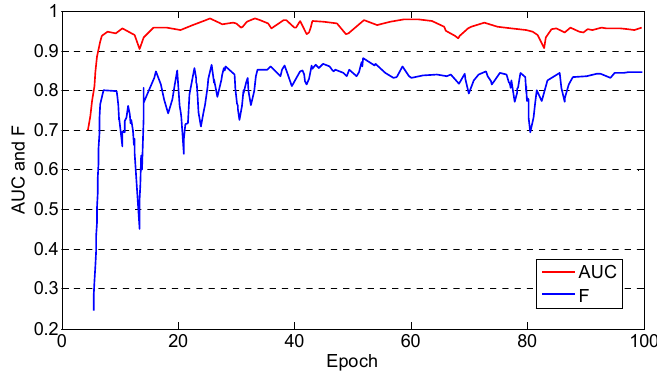
Figure 8. SCDAE convergence analysis.